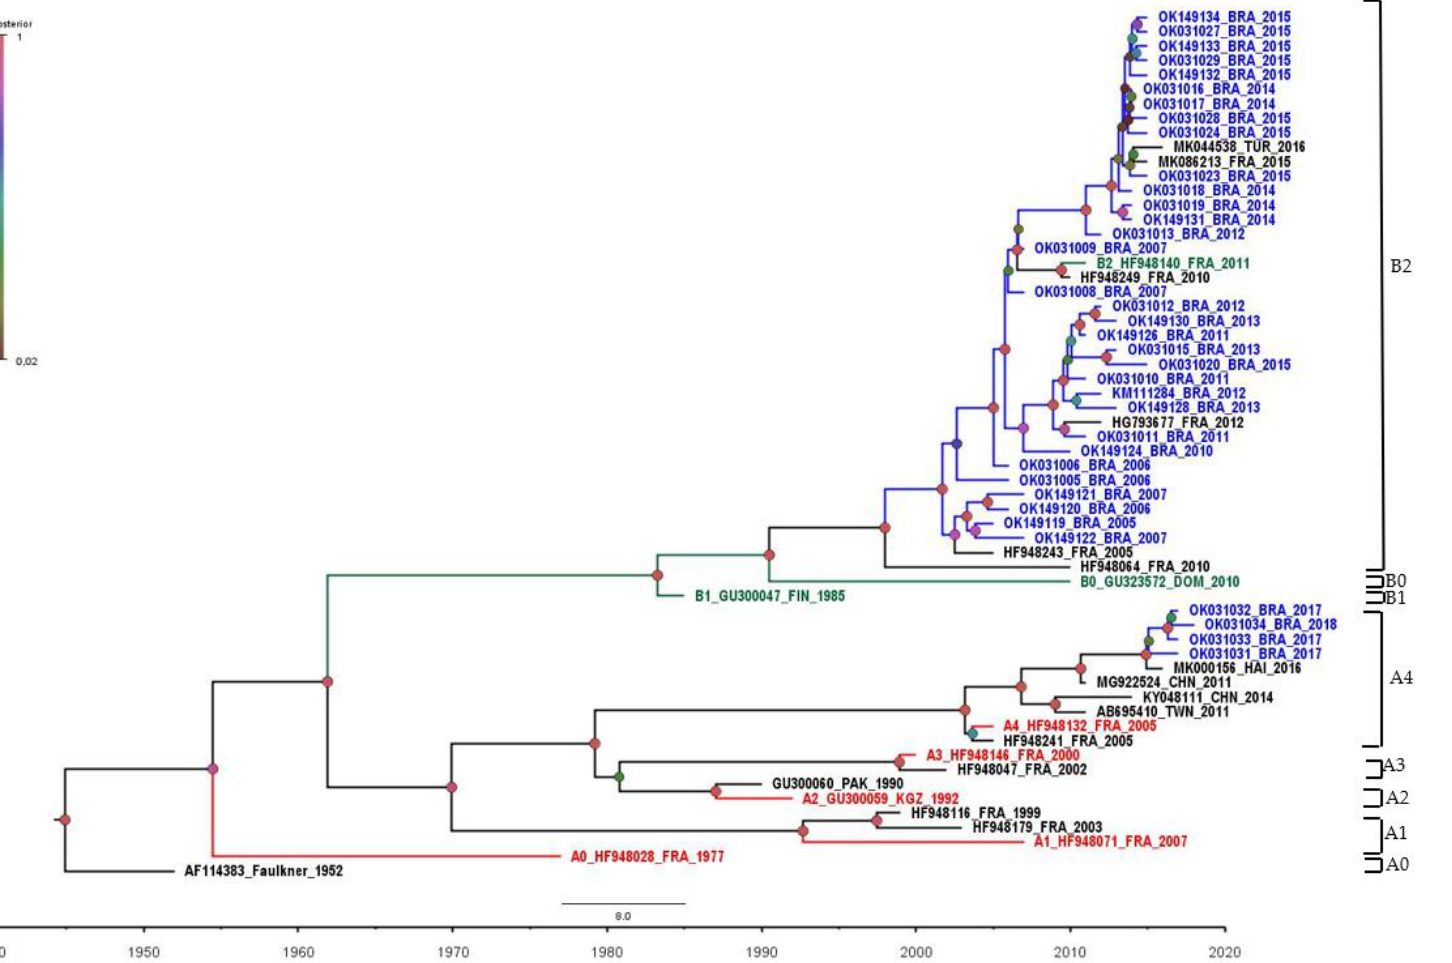
Figure 1. Phylogenetic reconstruction of CVB5 VP1 gene (849 bp), based on Brazilian isolates from meningitis and acute flaccid paralysis cases (represented in blue) and their closely related representative genotypes (represented in red, green and black) and sequences. In the temporal maximum clade credibility (MCC) tree, the posterior probabilities are shown on color and size scale. Scale—the node circle size is proportional to posterior probability support. The strain name, year of sampling, and GenBank accession numbers are also presented.